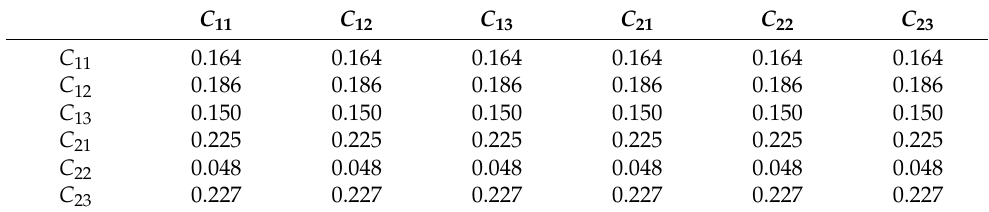
Table 3. Limit super-matrix.